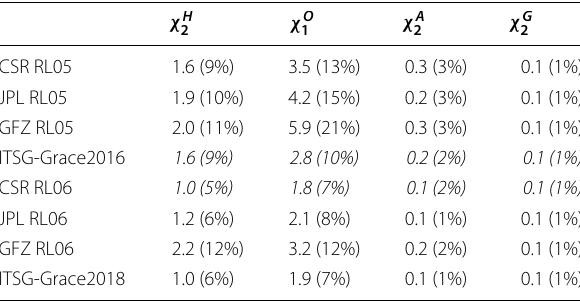
Table 4 Empirical standard deviations (mas) of the GRACE- based equatorial effective angular momentum functions for the continental hydrosphere (H), oceans (O), Antarctica (A) and Greenland (G)